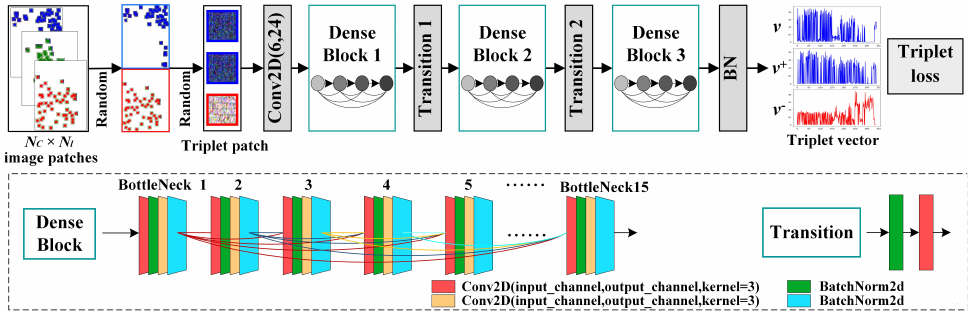
Figure 6. Multi-model Triplet